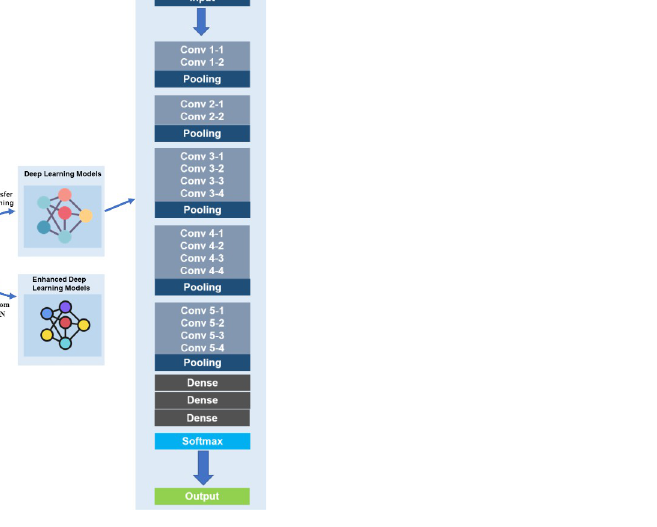
Fig 5. System architecture with VGG19